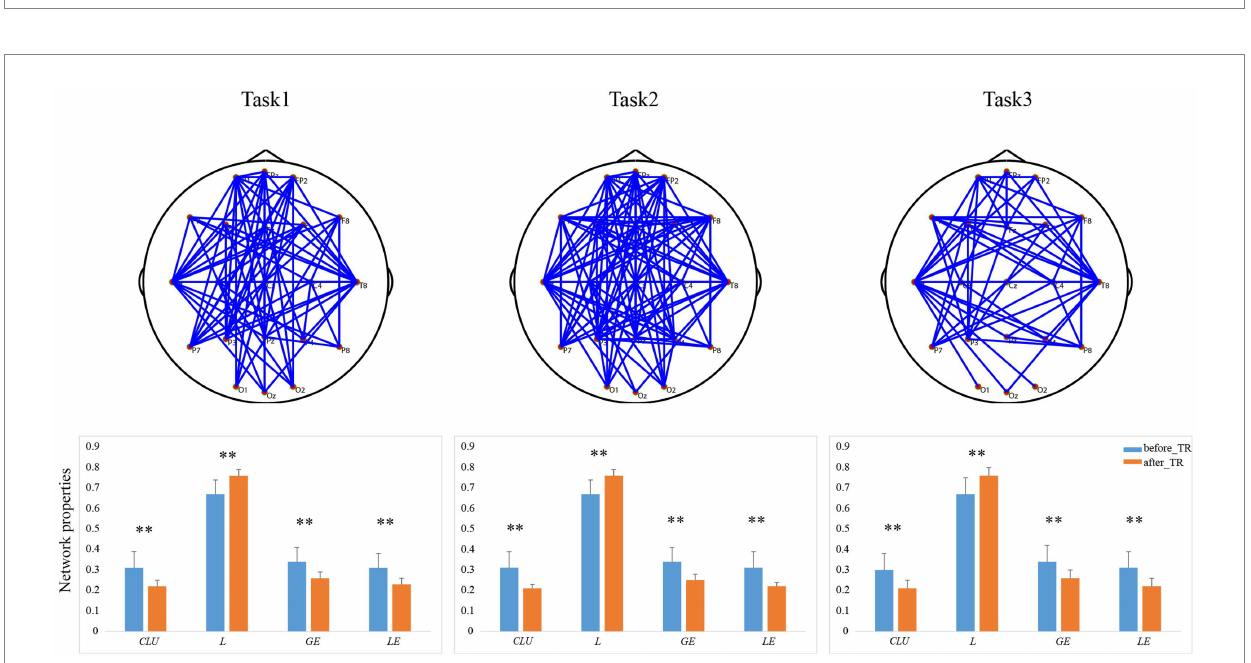
FIGURE 3 The PANSS scores for the before_TR group and the after_TR group. ** indicates p < 0.01.